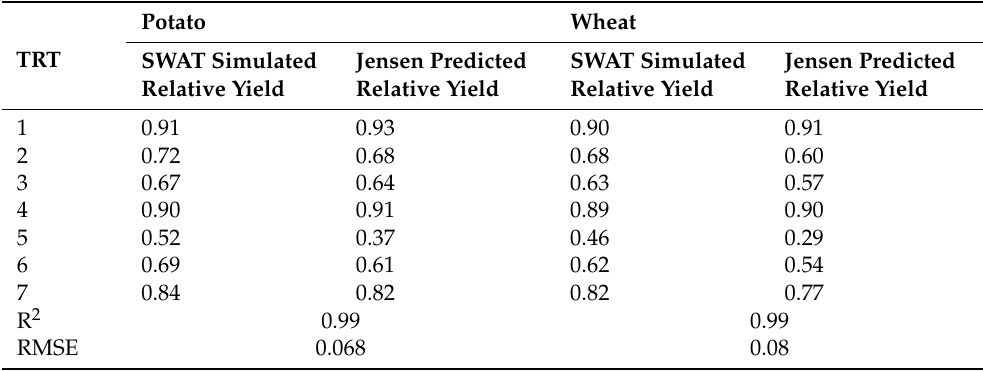
Table 6. SWAT-simulated and Jensen-model-predicted relative yield.